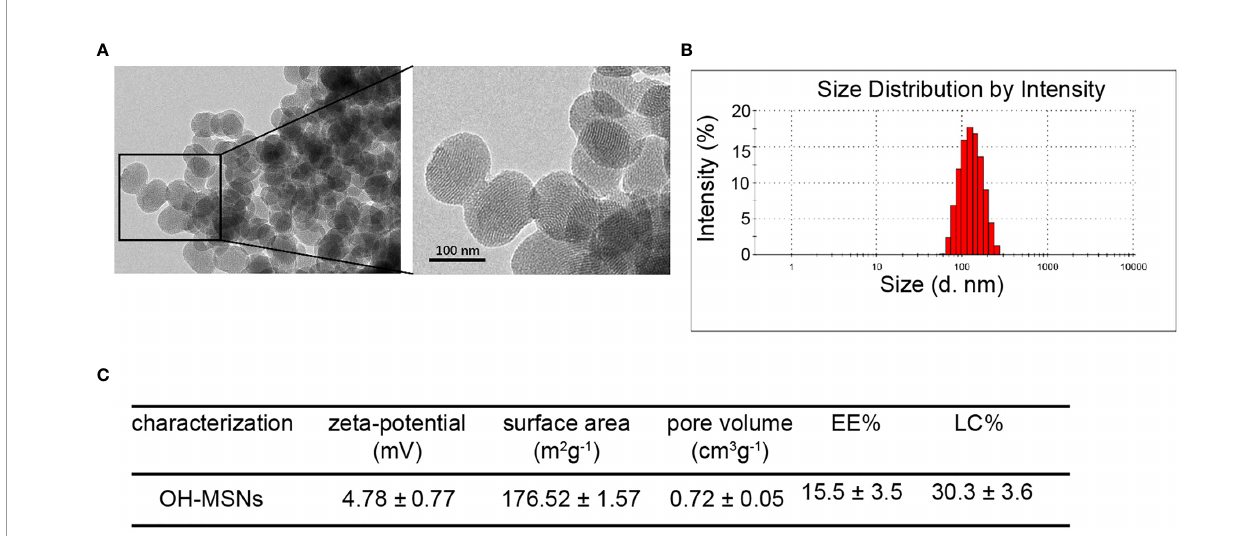
FIGURE 1 | OH-MSNs characterization. (A) The structure of OH-MSNs was assessedby transmission electron microscope(TEM). (B) The size distribution of OH-MSNs was analyzed by DynamicLight Scattering(DLS). (C) The characterizations, includingzeta-potential, surface area, pore volume, EE% and LC%,ofOH-MSNs were